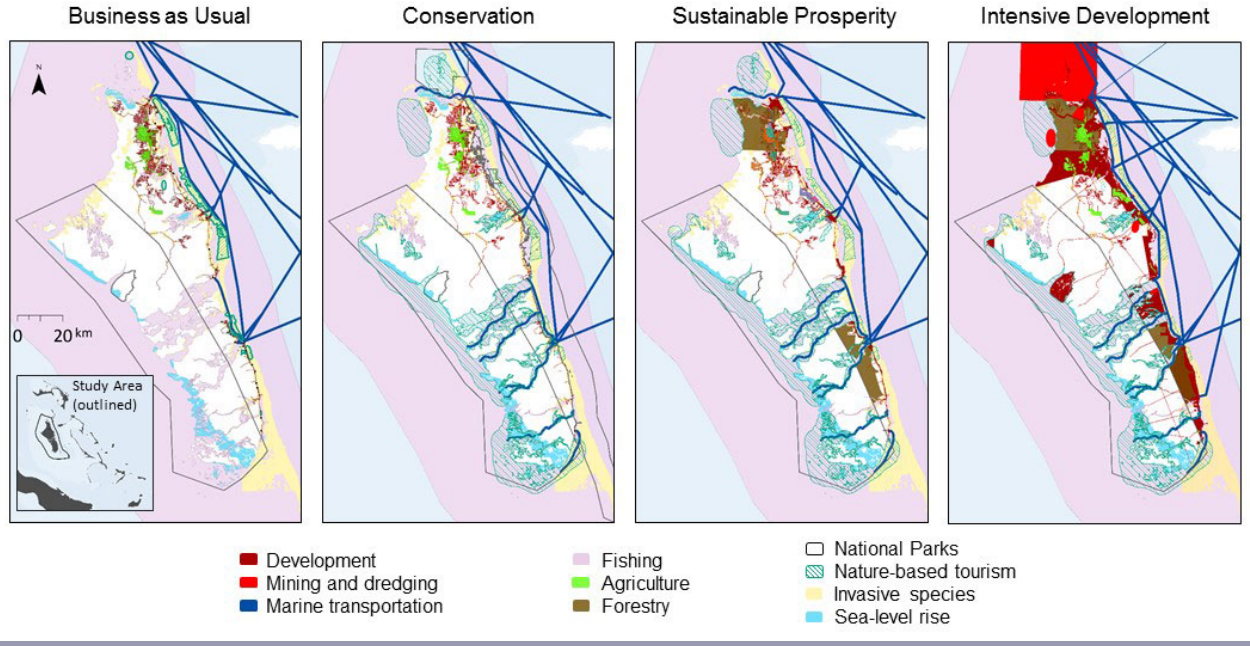
Fig. 5 . Maps of the final spatial depiction of the four future scenarios. Maps show the distribution of all human activities and stressors included in the scenarios and Habitat Risk Assessment. These were the results of several iterations of the process described in Figure 1 and were accompanied by scenario narratives and non-spatial data and parameters (Table